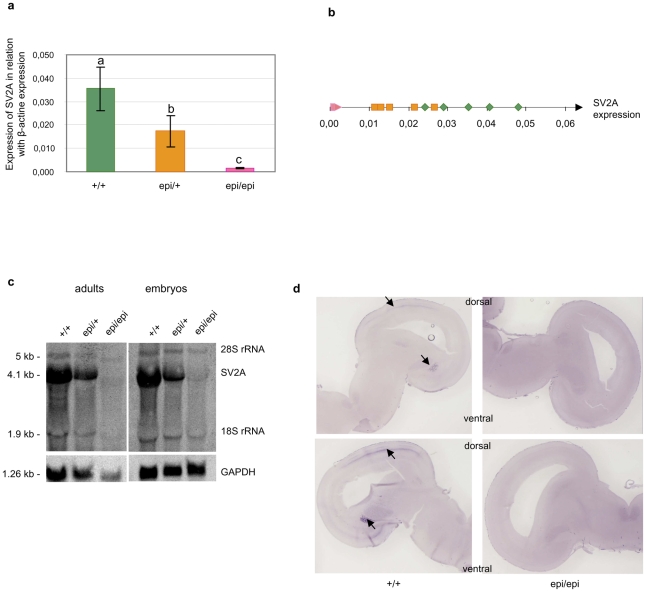
Expression analysis of SV2A in the Fepi chicken strain.(a) Real-time relative RT-PCR analysis showing the expression of SV2A versus that of β-actin in chicken embryos from the three genotypes (wild-type, carriers and epi/epi; n = 5 for each). The average SV2A expression was found to be higher in wild-type chickens compared to carriers and epileptic chickens, and in carriers compared to epileptics (p<0.003, Kruskal-Wallis test). (b) The relative expression in each tested embryo is shown in color by genotype: green, wild-type; orange, carrier; and pink, epi/epi. (c) Northern blot analysis showing that SV2A expression is highest in wild-type embryos and adults. Size estimations are indicated in kb. (d) In situ hybridization analysis of brains cross-sections from wild-type and epi/epi 17 day-old chicken embryos (E17). SV2A is clearly expressed in the mesencephalon of the wild-type embryonic brain (black arrow) but not in epi/epi embryos.